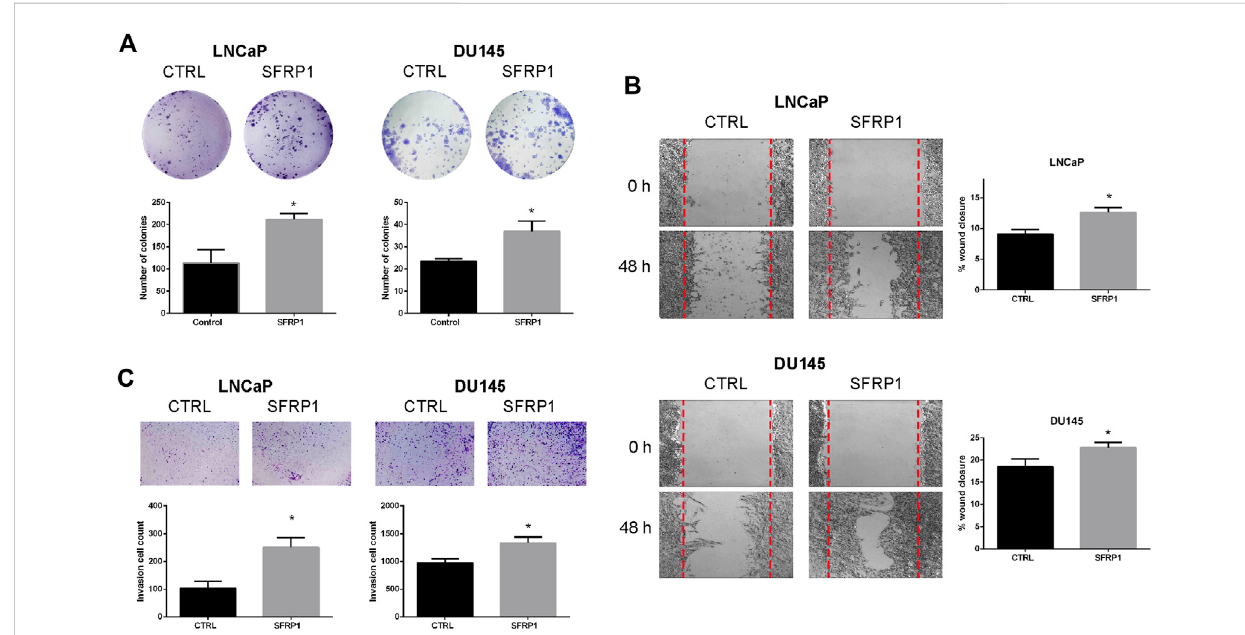
FIGURE 5 (A) The clonogenic ability of LNCaP and DU145 was analyzed. Cells were treated with SFRP1 or vehicle for 2 weeks, after incubation, cells were stainedwithcrystalvioletandanalyzedusingImageJsoftware. (B) CellmigrationofLNCaPandDU145cellswasdetectedbyawoundhealingassay.Cells weretreatedwitheitherSFRP1orvehiclefor48 hbeforetheirevaluation (C) .CellinvasionofLNCaPandDU145cellswasdetectedbytheTranswellassay. Cells were treated with either SFRP1 or vehicle and the invading cells were counted (* p 0.05).